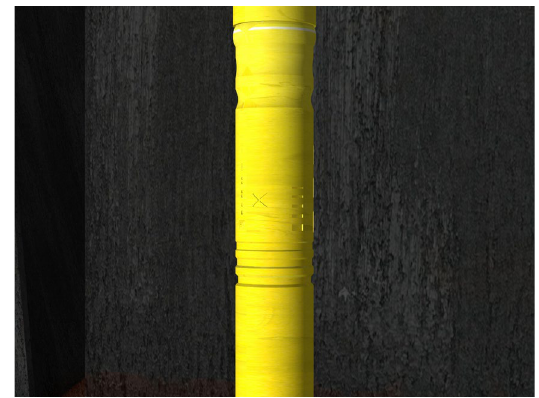
Figure 9. Sample of acquired image. The riser diameter is of about 300 mm. Some included riser artificial defects and artifacts; Camera FoV of 2.0 m x 1.5 m.